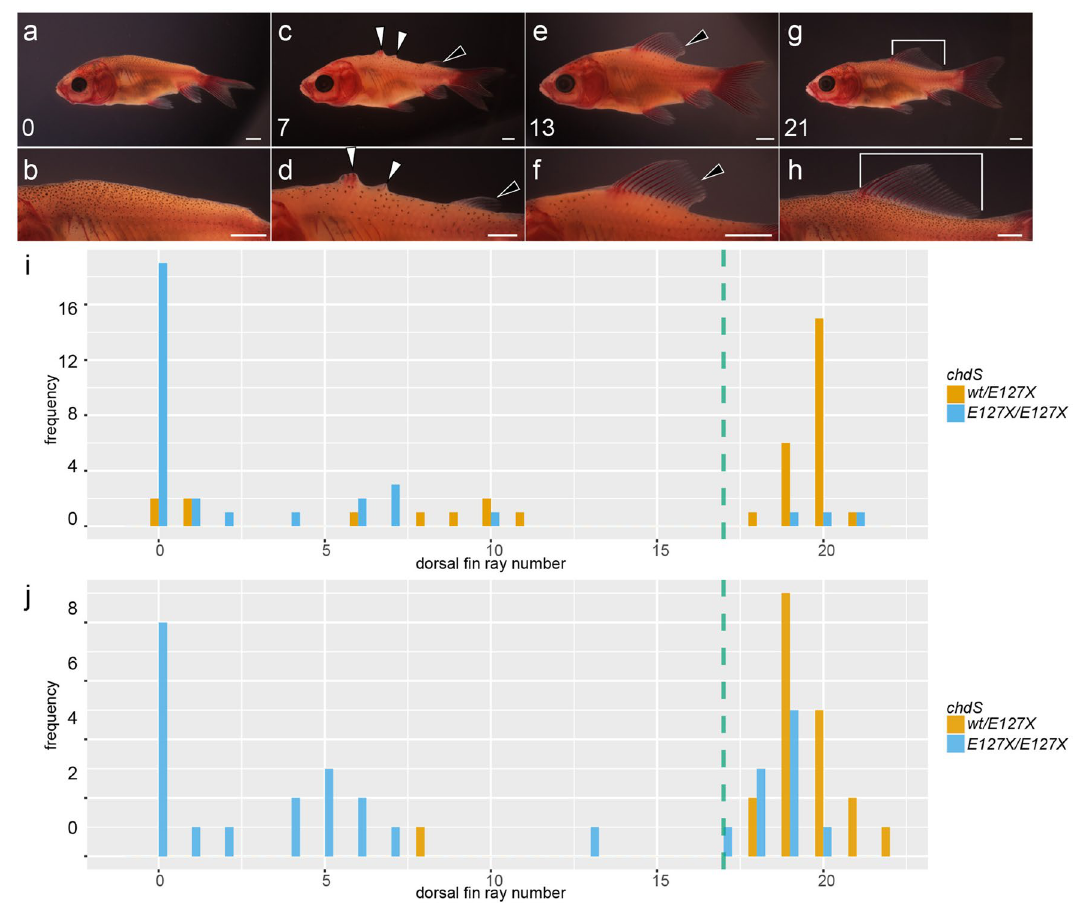
Figure 2. Dorsal fin phenotype in F2 hybrid. ( a – h ) Lateral views of the dorsal region [three representative variations of dorsal-finless mutants with bifurcated caudal fins ( a – f ) and wildtype ( g , h )]. Numbers in the lower left corner indicate the number of dorsal fin rays including serrated dorsal fin spine and poste-serrated dorsal fin spine rays (please see text in details). Panels of ( b ), ( d ), ( f ), and ( h ) are magnified views of ( a , c , e , and g ), respectively. ( i , j) Histograms of distribution patterns of dorsal fin ray number of chdS wt/E127X and chdS